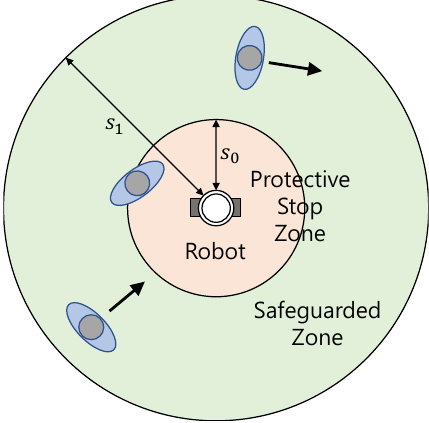
Figure 1. Mobile robot with 2 distinctive safety-related